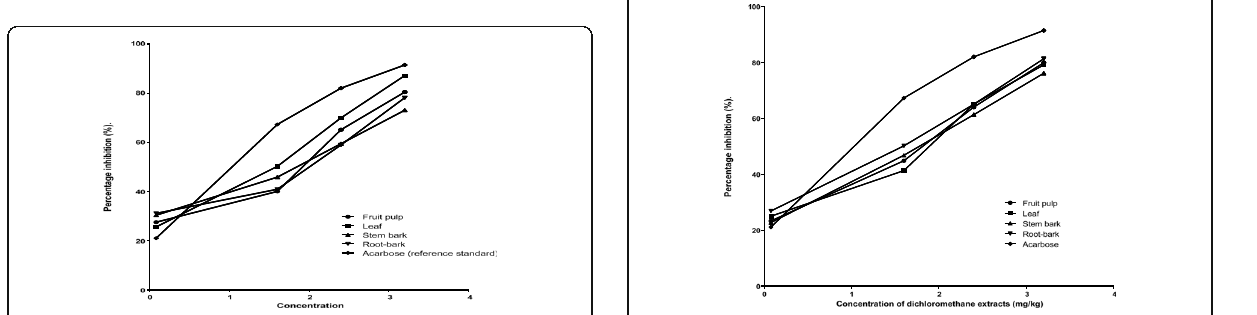
Fig. 8 Percentage inhibition of α -amylase by dichloromethane extract of Annona muricata fruit-pulp, leaf, stem-bark, root-bark and acarbose (reference